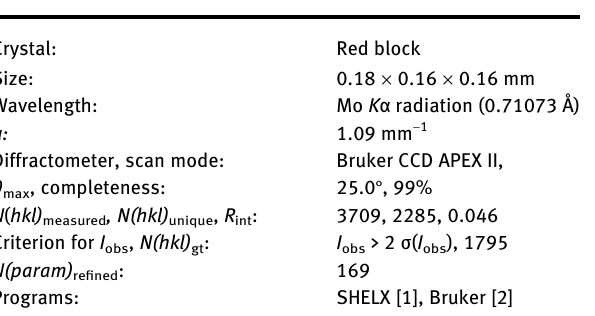
Table  : Data collection and handling.